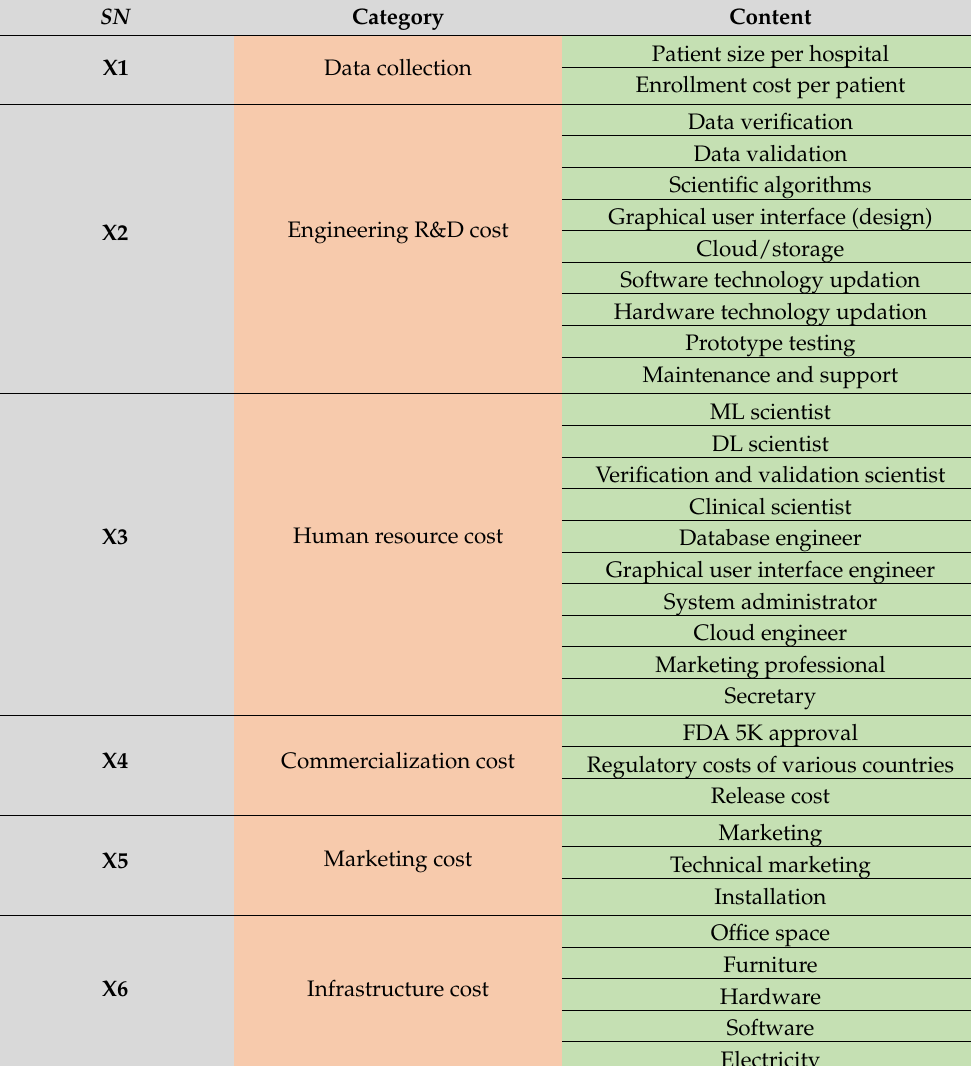
Table A3. AI content considered for cost